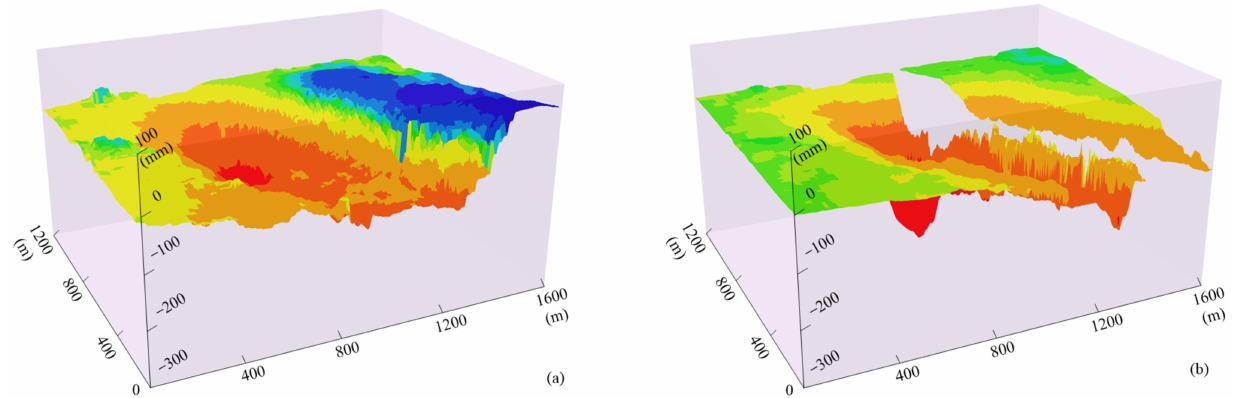
Figure 15. The 3D deformation maps; ( a ) 3D LOS deformation; and ( b ) 3D deformation of proposed